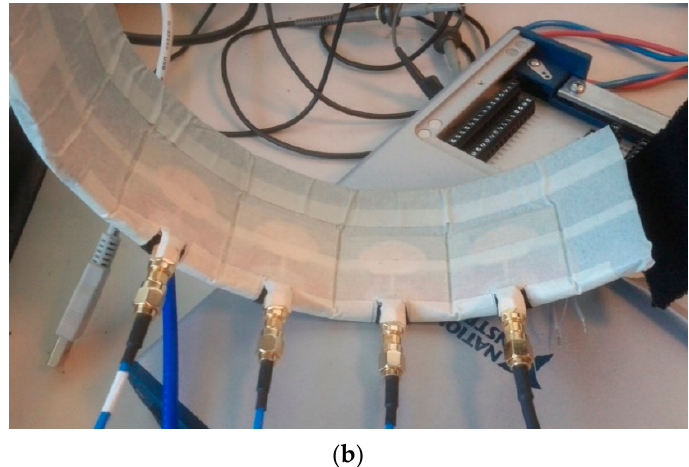
Figure 4. Concept and implementation of sensor array for application at the upper arm to measure pulse wave. The electrical setup consists of four antennas connected to a multiplexer with a pulse generator and detector with digital signal processor (DSP) and a wireless communication interface ( a ). The antenna setup and cabling for a prototype ( b ) is to be wrapped around the upper arm.